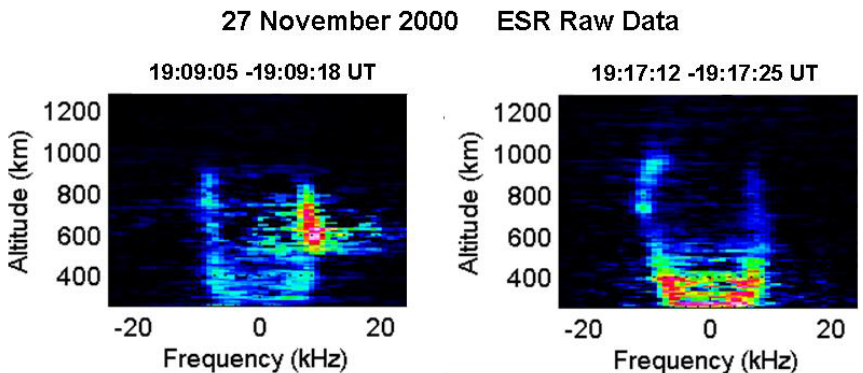
Fig. 2. Examples of NEIALs observed in the raw data. The enhancement in the right shoulder (left panel) corresponds to the time when the green emission line exceeds the red